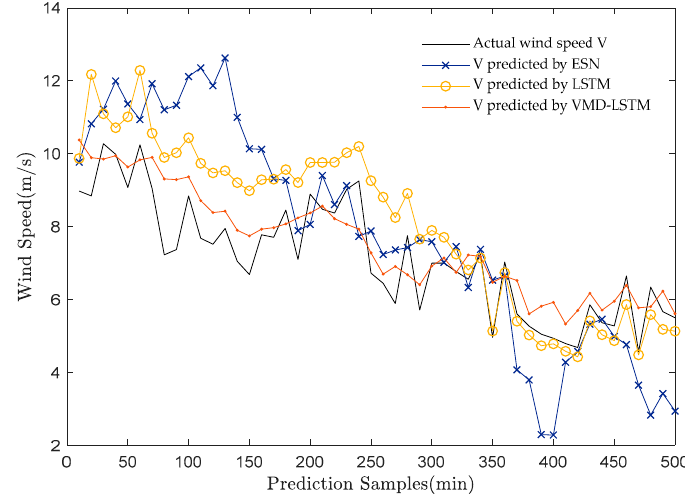
Figure 14. The results of comparison models (ESN and LSTM and VLSTM).